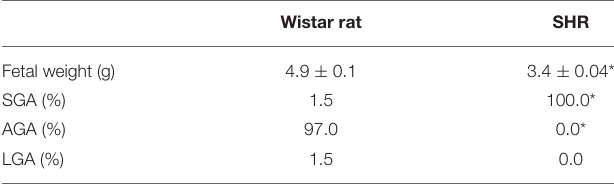
TABLE 2 | Fetal parameters from Wistar rats and